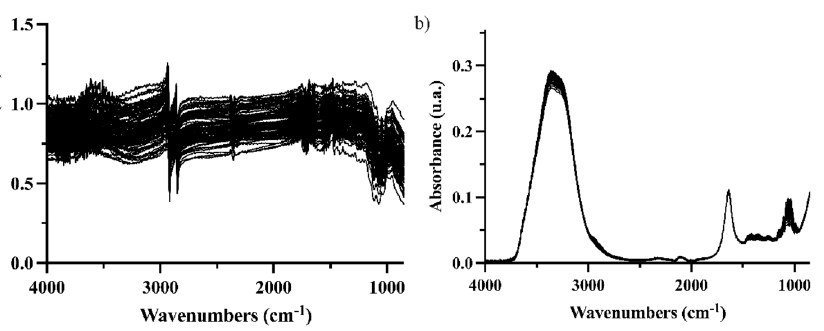
Figure 1. Spectra of 90 grapes using different IR analysis configurations ( a ) DRIFT for intact berries; ( b ) ATR-FTIR for crushed berries.